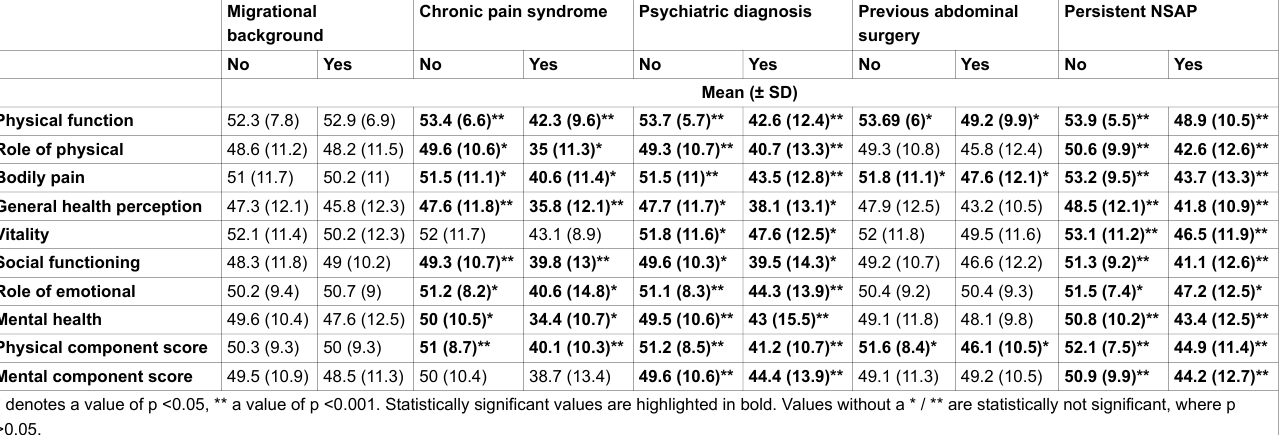
Table 4: Analysis of mean (± SD) physical and mental component scores influencing NSAP. The analyses of the risk factors predictive for the different SF-36 ® scores are adjusted for age and gender.